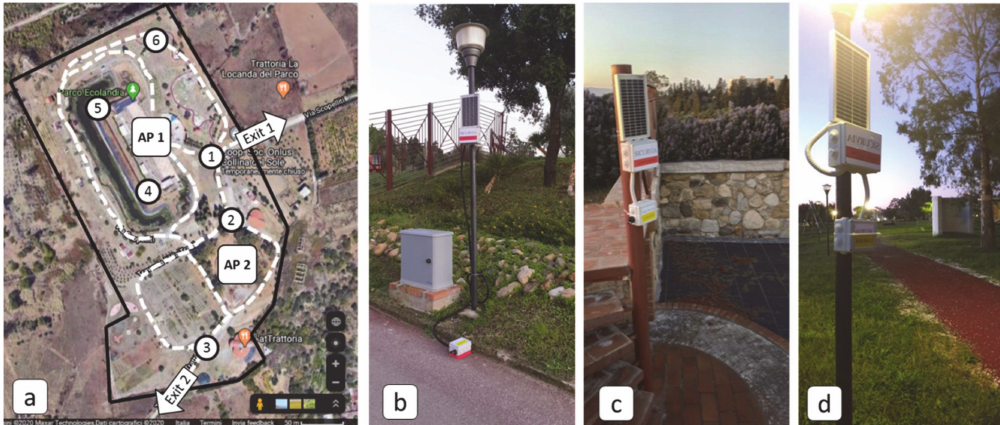
Figure 2. ( a ) Map of the theme park where the WSN was installed and three self-powered